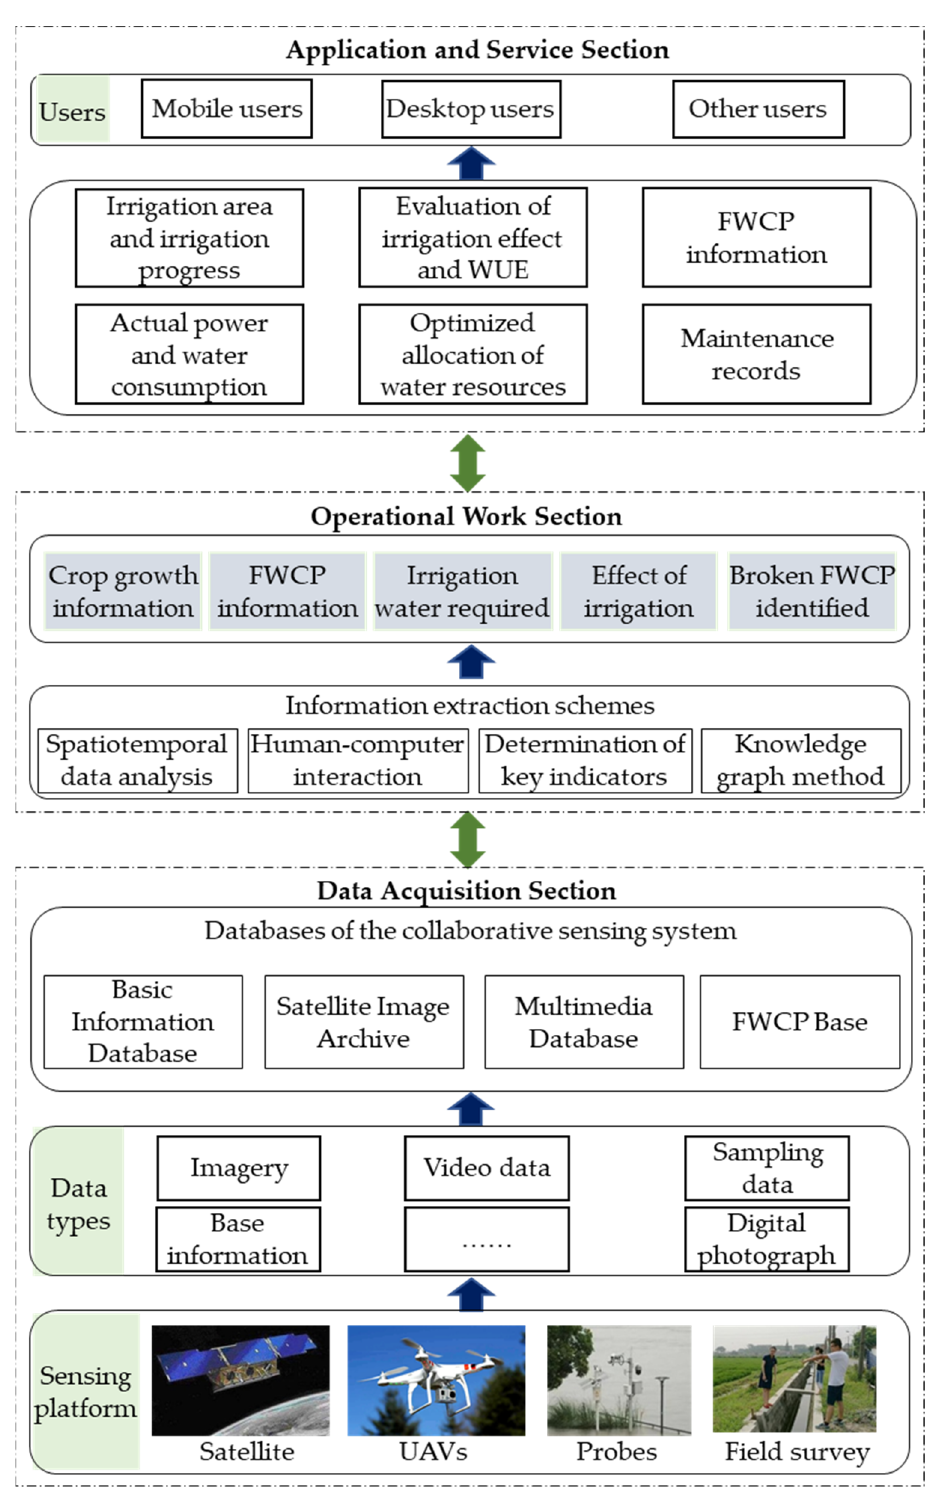
Figure 2. Architecture of collaborative sensing system for farmland water conservancy project maintenance.